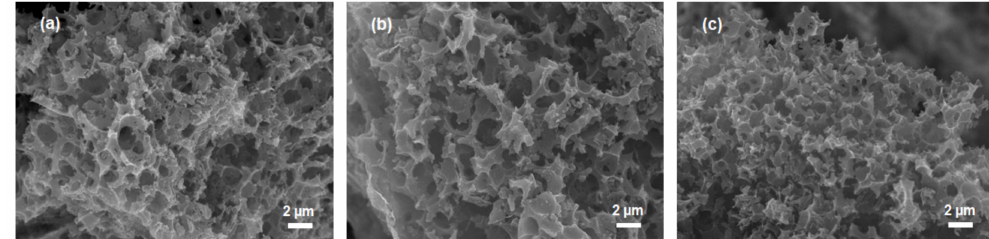
Figure 2. SEM images of: ( a ) SRAC10 powder; ( b ) SRAC7 powder; and ( c ) SRAC5